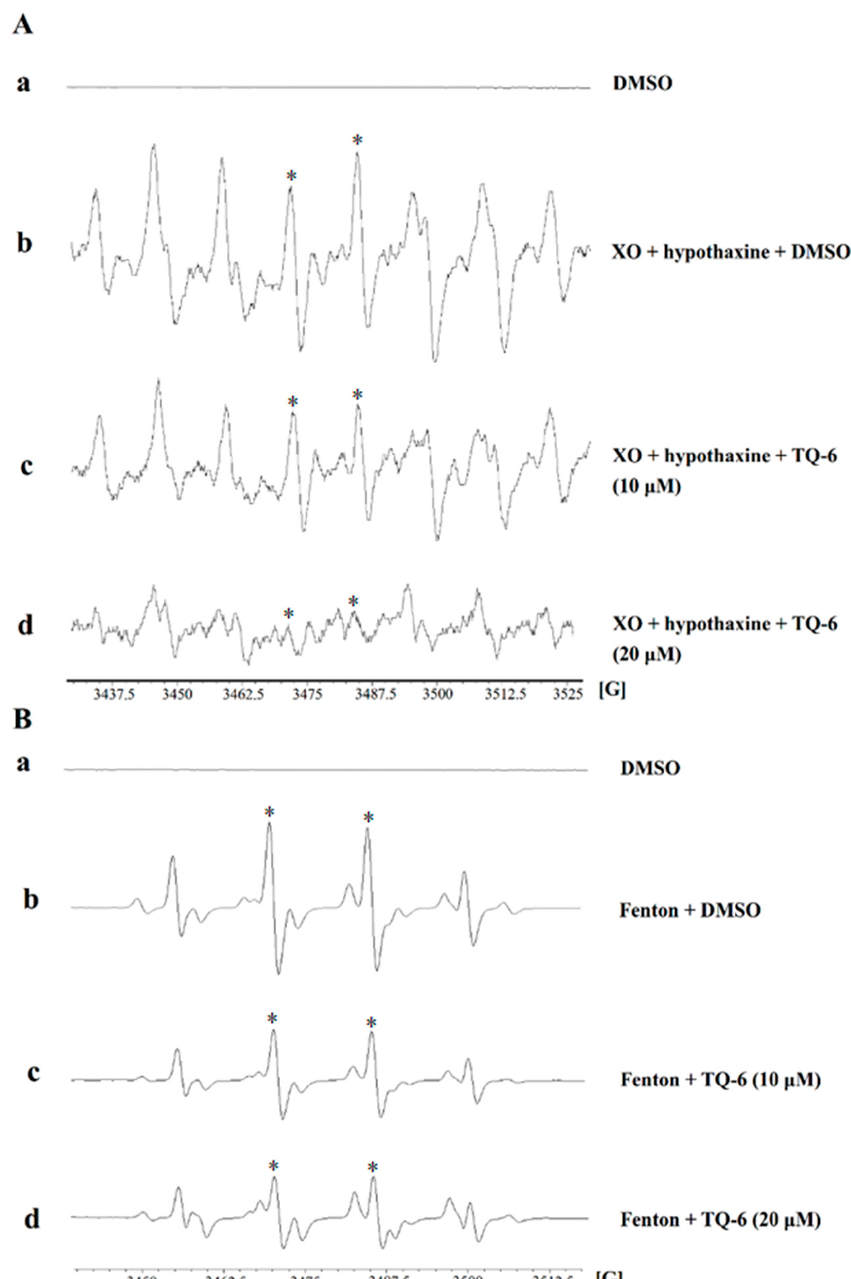
Figure 2. Effect of TQ-6 on the xanthine/xanthine oxidase system-generated 5-Diethoxyphosphoryl- 5-methyl-1-pyrroline N-oxide (DEPMPO)-superoxide spin adduct and Fenton reaction solution ( n = 4). ( A ) The ESR settings were followed as described in Figure 1; however, KO 2 was absent, and 36 µ M xanthine and 32 mU/mL xanthine oxidase were present. Line a, DMSO (0.1%); Line b, DMSO; Line c, 10 µ M TQ-6; and Line d, 20 µ M TQ-6. ( B ) The reaction mixture contained 1 mM Fe 2+ , 1.0% H 2 O 2 , and 200 mM DMPO in the presence or absence of TQ-6. The horizontal axis means the magnetic field